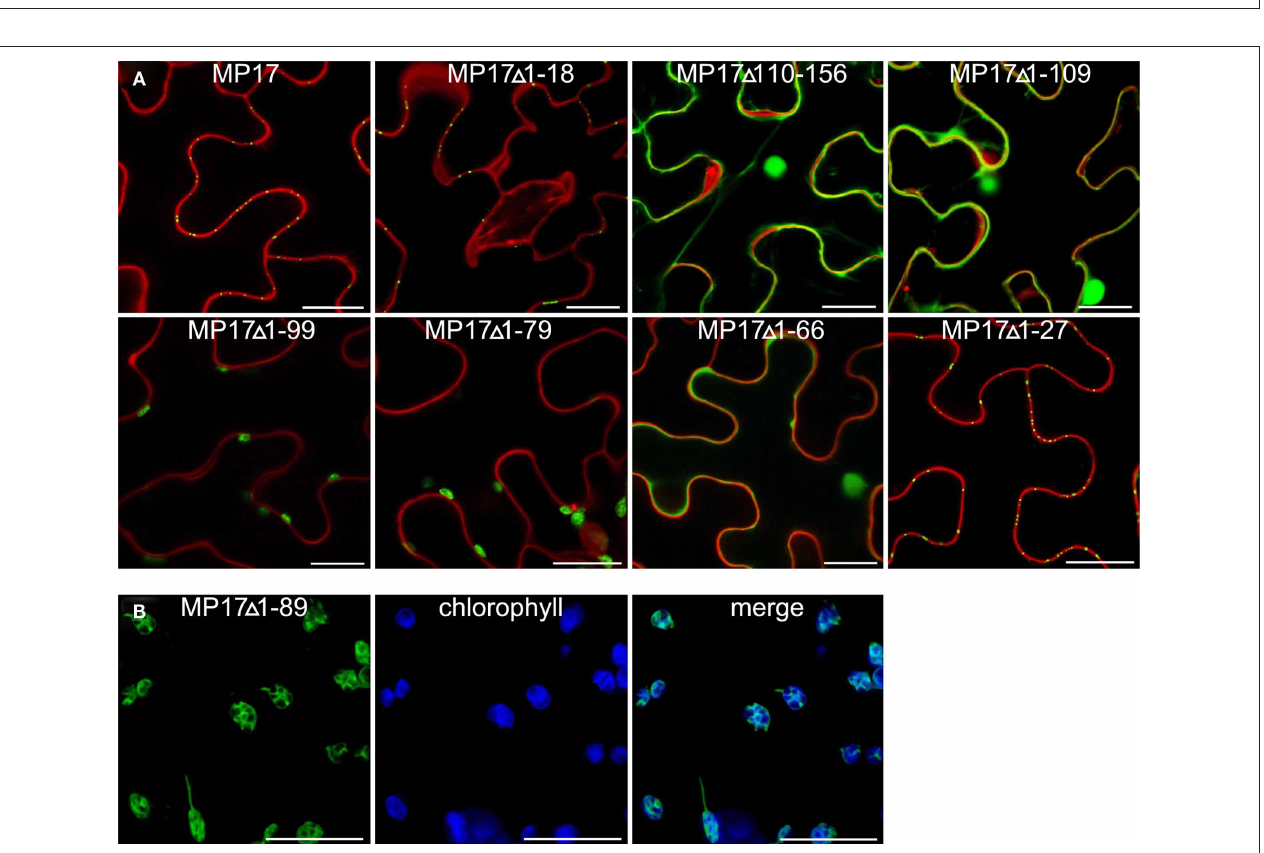
FiguRe 1 | MP 17 deletion variants. Schematic overview of MP 17 protein structure with disordered (black) or globular domains [middle gray] according to “GlobPlot” and intracellular localization of the respective C-terminal GFP fusion proteins. The wild-type MP 17 depicts the areas of disordered domain 1 (DDI; aa 5–18), DDII (aa 30–37), DDIII (aa 110–143), the positions of the four phosphorylated serines and the putative domains for homodimerization (HD; aa 38–54) and nucleic acid binding (NBD; aa 57–156).